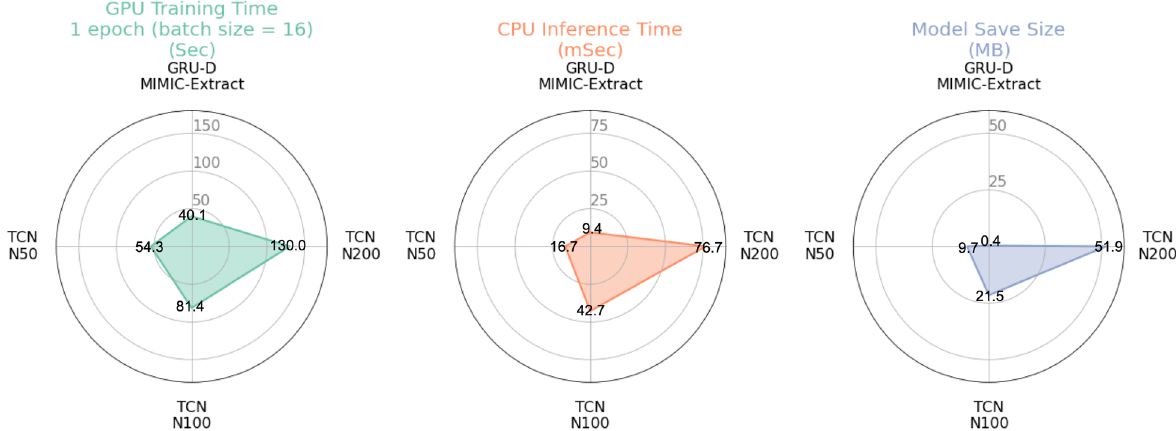
Figure 3. Comparing the computational complexity of the advanced baseline GRU-D model to three different TCN configurations. TCNs generally require less training time per model parameter than the GRU-D on